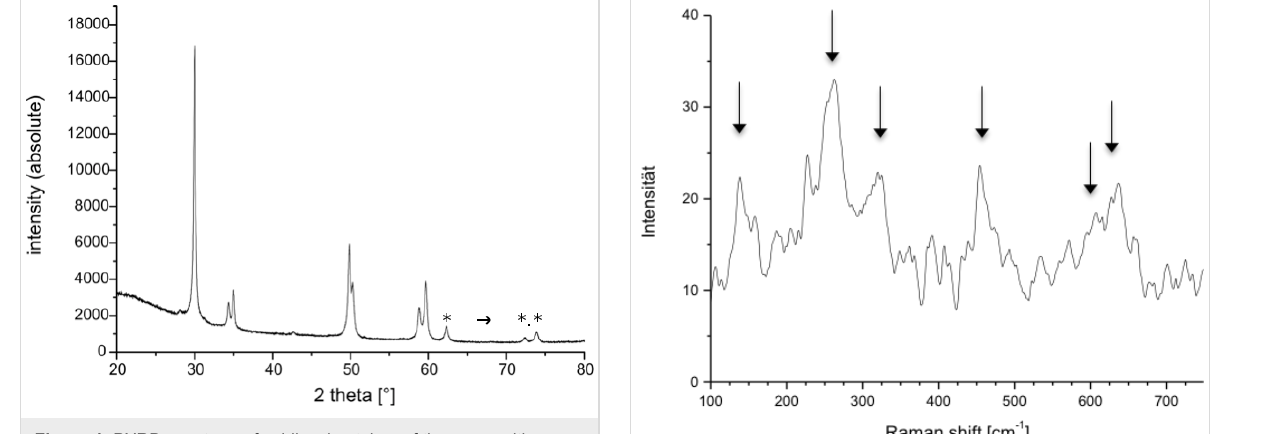
Figure 4: PXRD spectrum of oxidic microtubes of the composition Ce 0.13 Zr 0.87 O 2 @SiO 2 . Main diffraction peaks 2 Φ ° [(rel).: 29.968 [101] 999, 34.328 [002], 166, 34.977 [110], 200, 49.825 [112], 355, 321, 50.305 [200], 225, 58.819 [103], 225, 59.676 [211], 237. JCPDS # 88-2397 for Ce 0.12 /Zr 0.88 O 2 : 29.957 [101], 999; 34.320 [002], 83; 34.930, [110], 136; 49.778 [112], 321; 50.231 [200], 170, 58.787 [103], 113; 59.516 [211], 214. * not assigned.